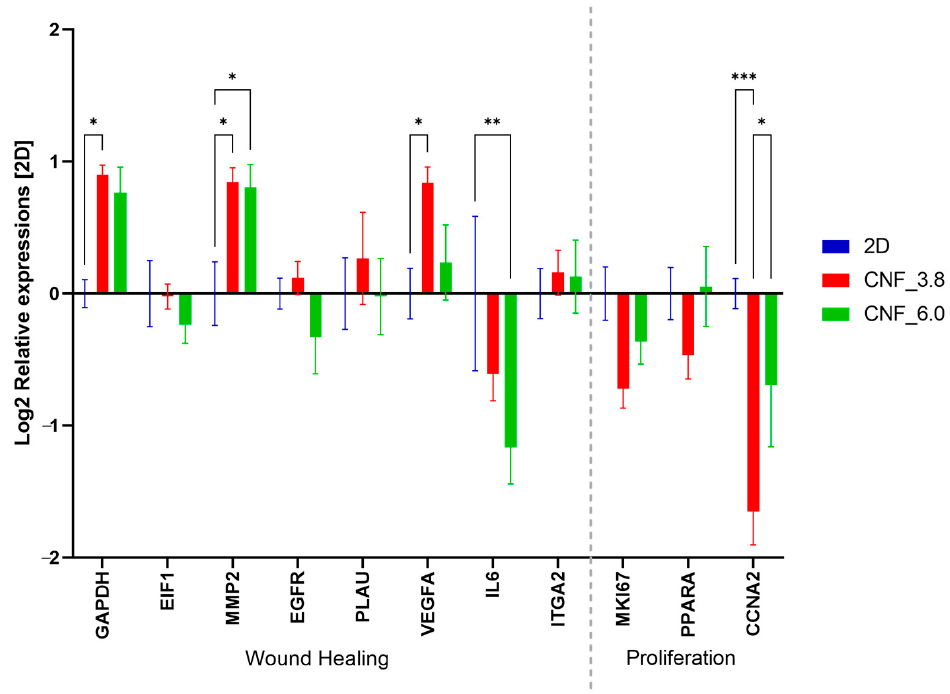
Figure 7. The microenvironment of 3D-printed TEMPO CNF scaffolds affects the expression of genes related to wound healing and proliferation. Gene expression changed on fibroblasts cultured for 2 weeks in 3D-printed TEMPO CNF scaffolds and 72 h in 2D were analyzed by qPCR. Relative expressions were adjusted to the gene expression of the 2D control, set to zero for each gene. Staples represent the average and error bars standard error of the mean (n = 9). Two-way ANOVA; Tukey’s post hoc test for multiple comparisons (2D). * p -value < 0.05, ** p -value < 0.01, *** p -value <